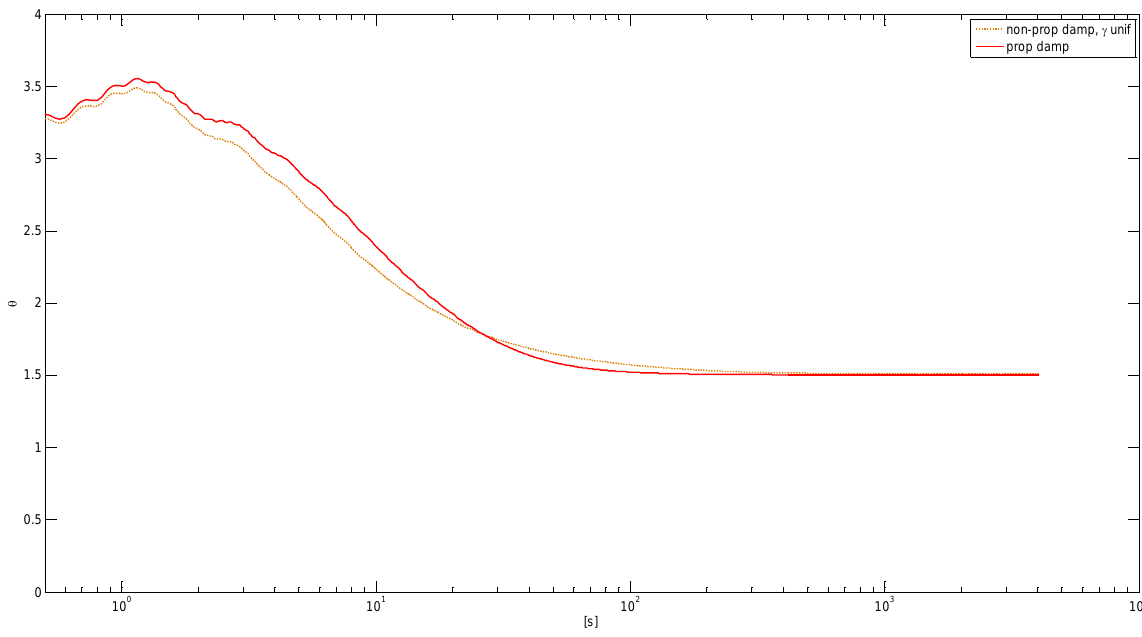
Fig. 17. Energy coupling index versus time, x, y axes in log scale, for proportional and non-proportional damping, in solid and dashed lines, respectively.